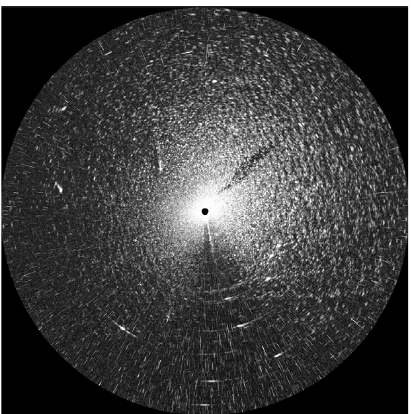
Figure 5. Synthetically generated marine radar oil spill image sample.